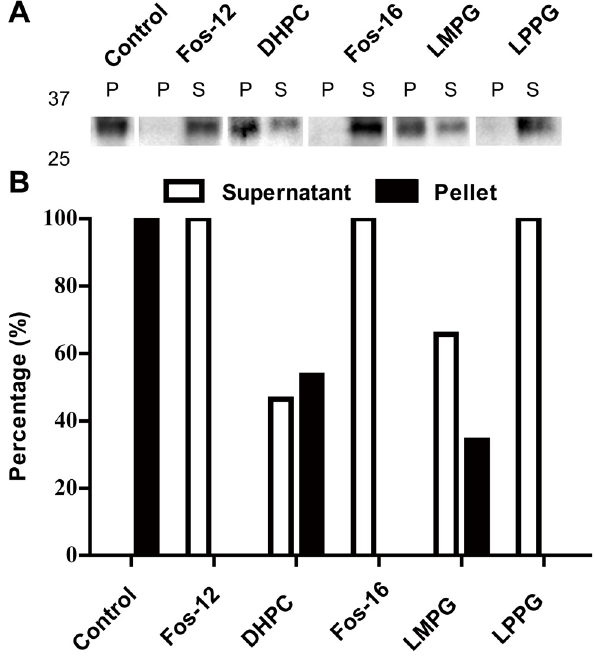
Figure 1. Resolubilization screening of P-CF produced mAQP4 M23. The pellet from the P-CF reaction mix was resuspended